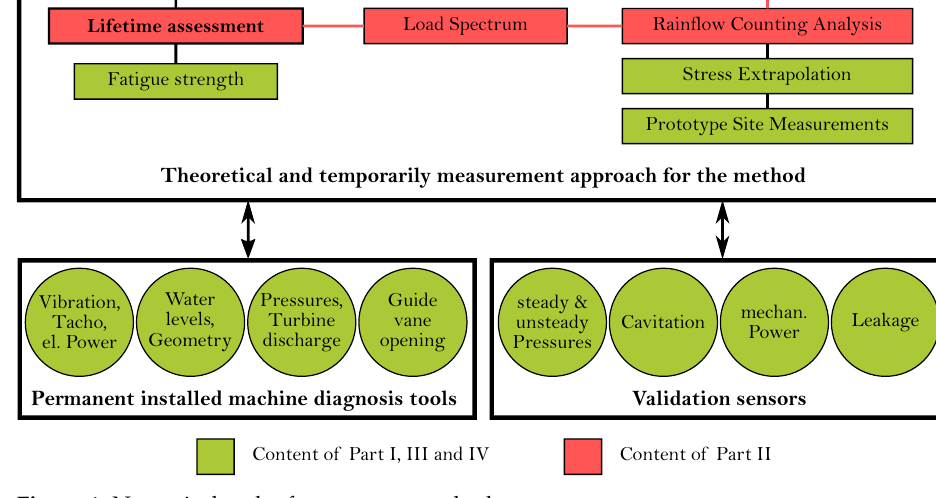
Figure 1. Numerical path of assessment